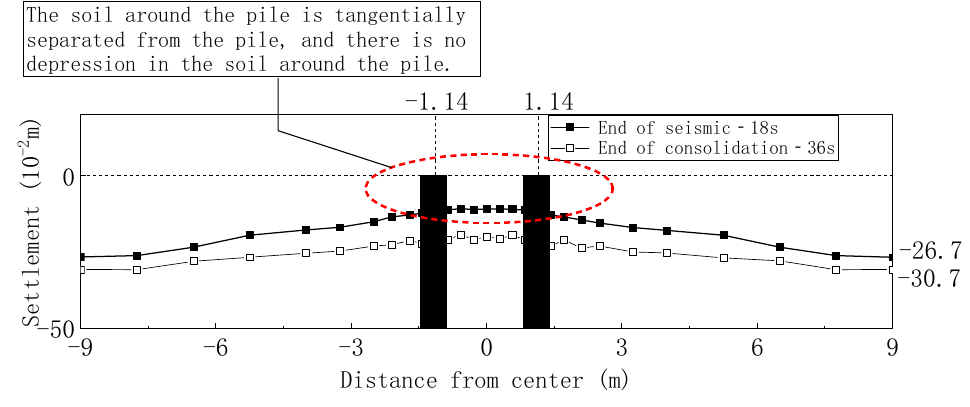
Figure 14. Simulation settlement profile at ground surface.